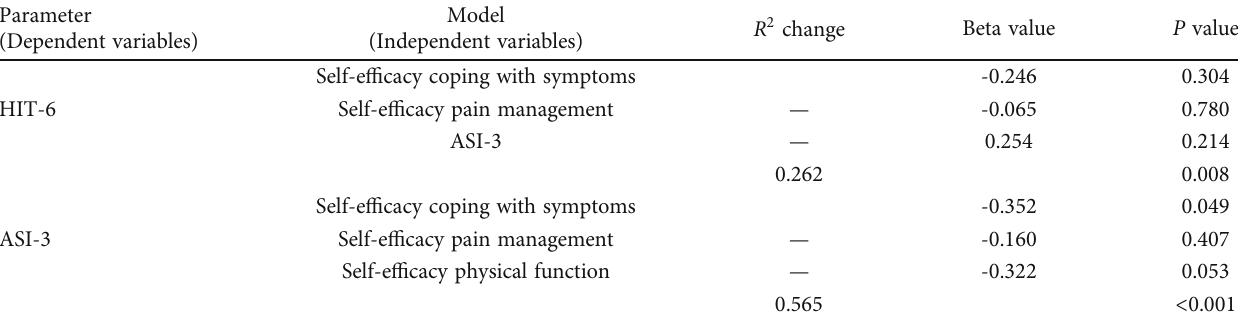
Table 3: Multivariate predictive analysis of headache impact and anxiety